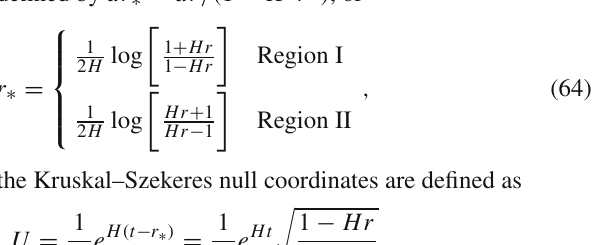
Fig. 4 An example of type 1 island I (thick blue line) and region G (think red dashed line). The directions of the Kruskal–Szekeres coordi- nates U and V are also